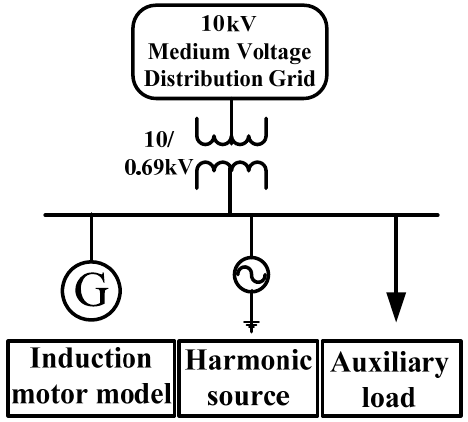
Figure 5. The diagram of the harmonic source model of